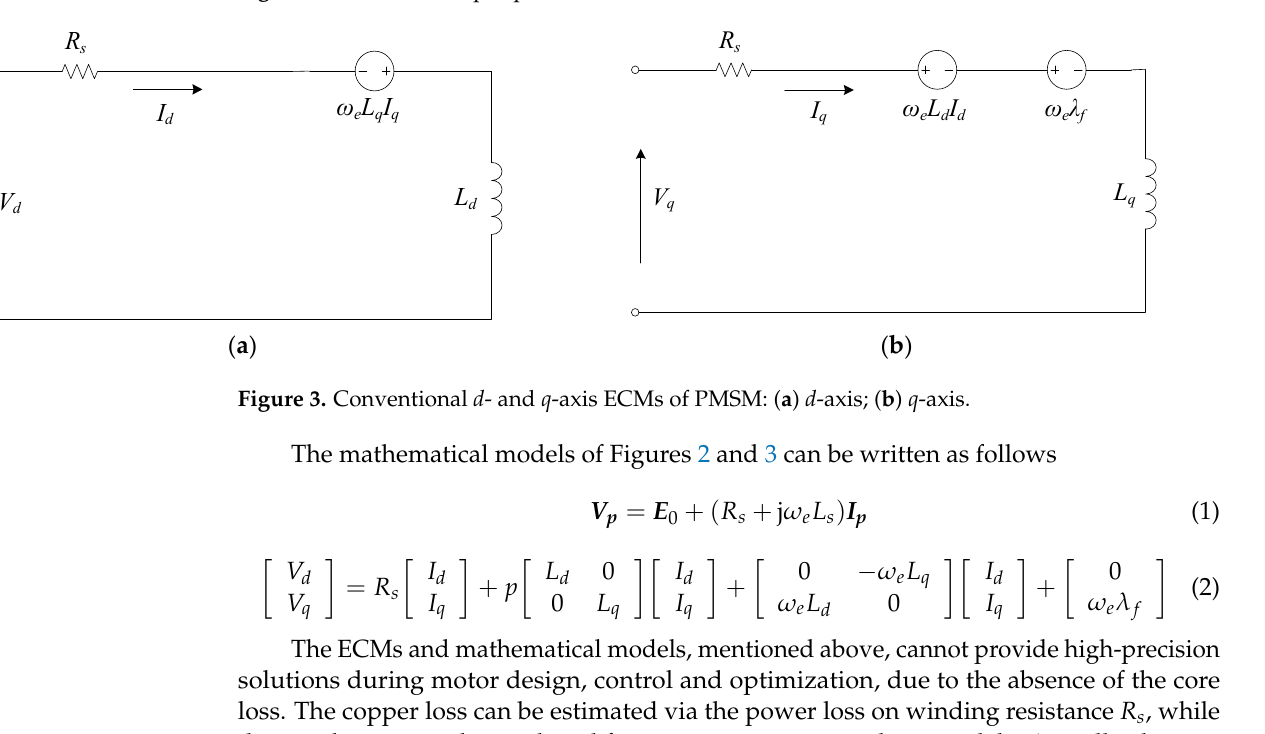
Figure 2. Conventional per-phase ECM of PMSM.